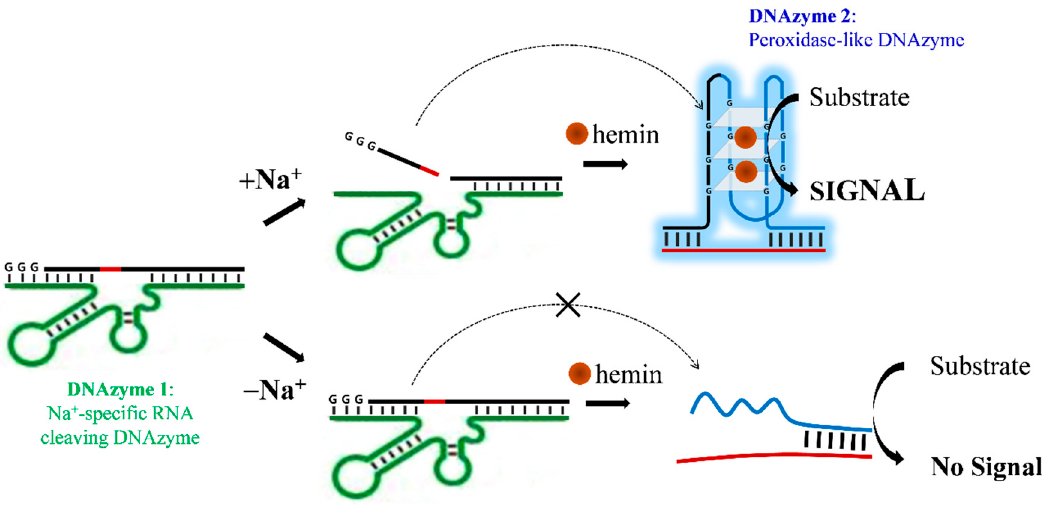
Figure 1. Schematic representation of DNAzyme-based detection of sodium ion (Na + ). This assay consists of two different DNAzymes: DNAzyme 1 (Na + -specific RNA-cleaving DNAzyme) as a target recognition element and DNAzyme 2 (peroxidase-like DNAzyme) as a signal generator. The short DNA fragment released by Na + -triggered DNAzyme 1 fully activates DNAzyme 2 in the presence of hemin (co-factor) and the measurement mode can be varied depending on the substrates used.